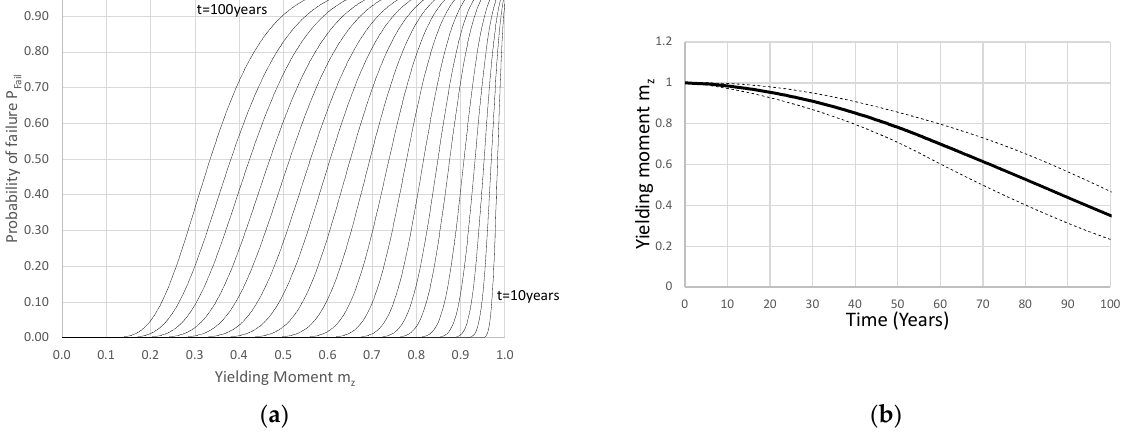
Figure 4. Reinforced concrete bridge on the Corace River, simulation of deterioration history of the road beam current section. Time evolution of the ultimate bending moment from 10 to 100 years of service life [ m z = M z ( t )/ M z0 ]. ( a ) Curves of probability of failure vs. given deterministic levels of the demand (Δ t = 5 years); ( b ) probabilistic parameter evolution: mean μ (thick line), standard deviation σ from the mean μ (dotted lines).